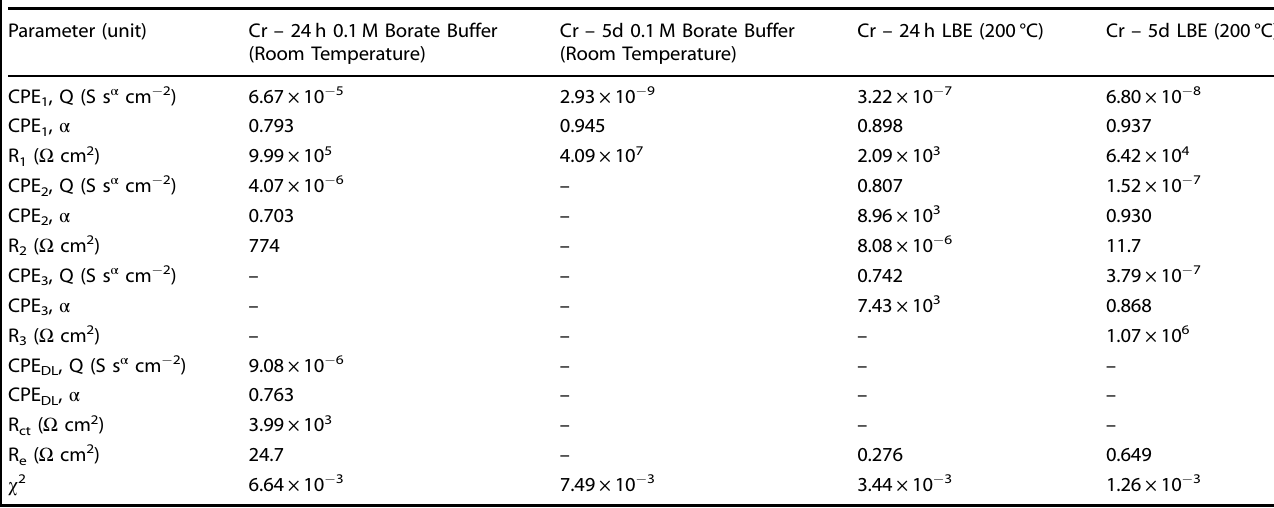
Table 2. The fi tting parameters for impedance spectra shown in Fig. 9.